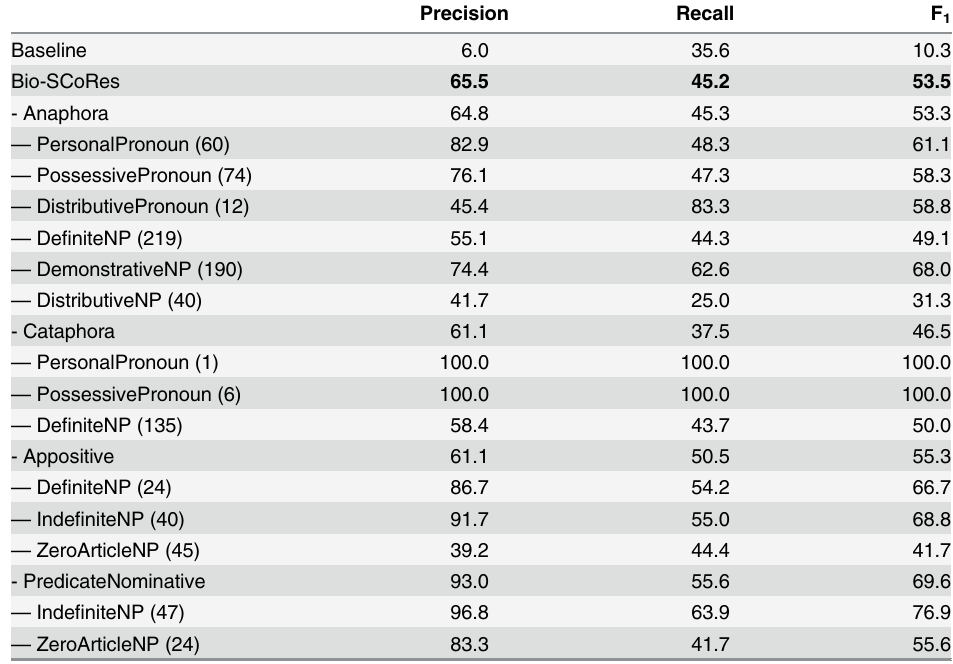
Table 9. Evaluation results for coreference resolution on the test portion of SPL coreference